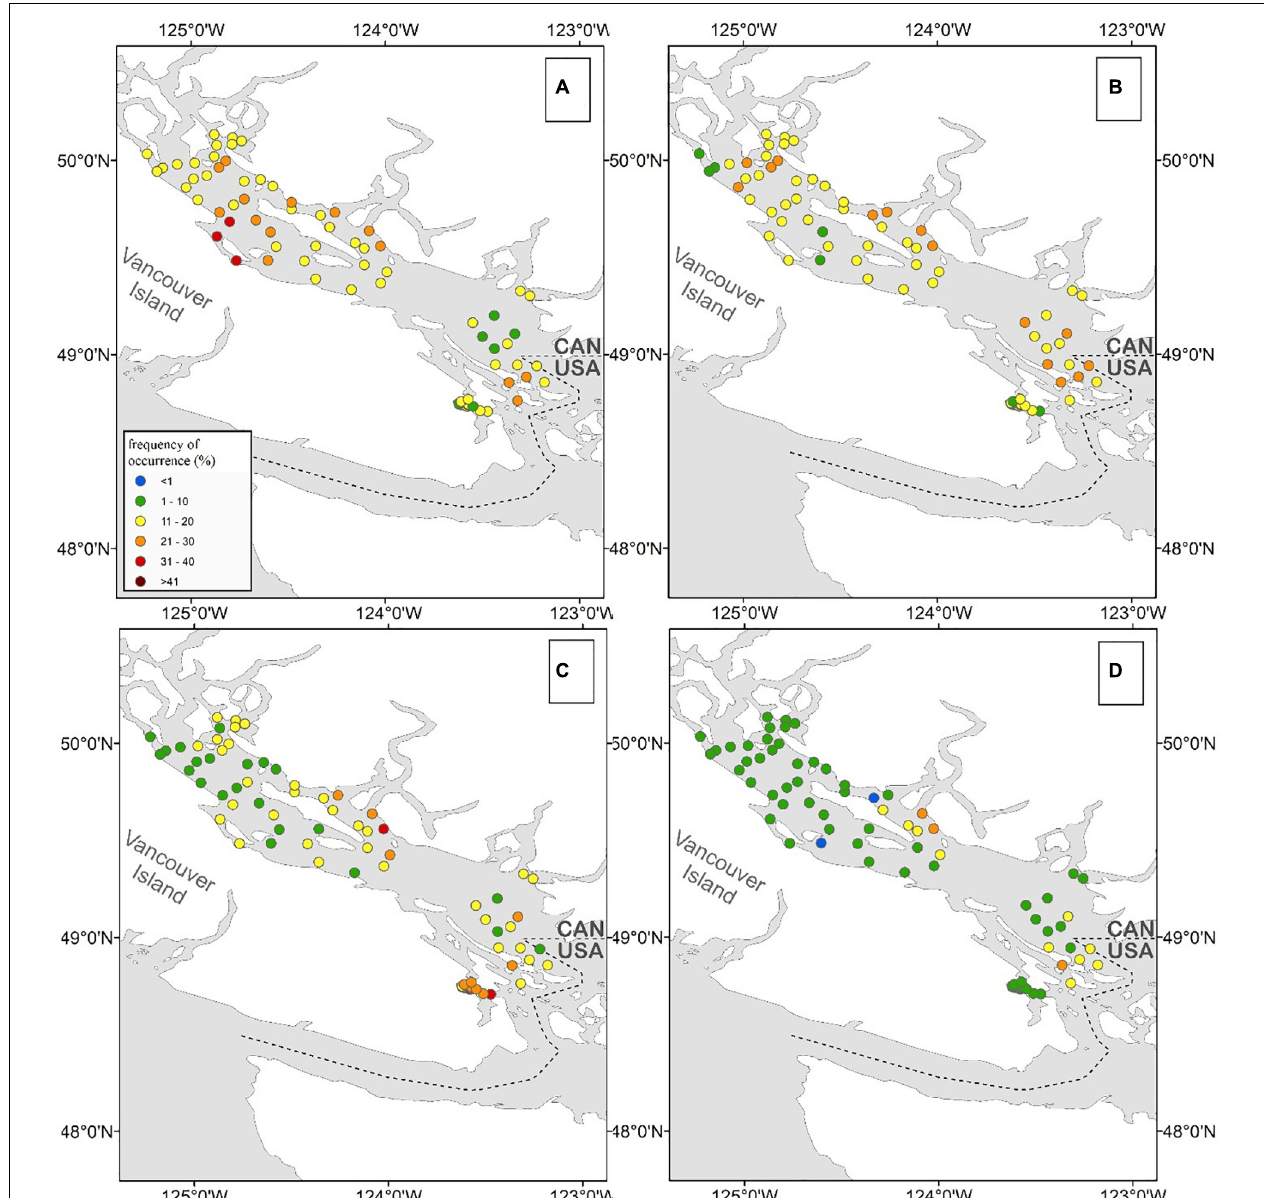
FIGURE 6 | Average 2015–2018 frequency of occurrence (%) of Rhizosolenia setigera (A) , Dictyocha spp. (B) , Alexandrium spp. (C) , and Heterosigma akashiwo (D) in surface samples. Stations with at least 40 measurements within 4 years (10 per each year) were